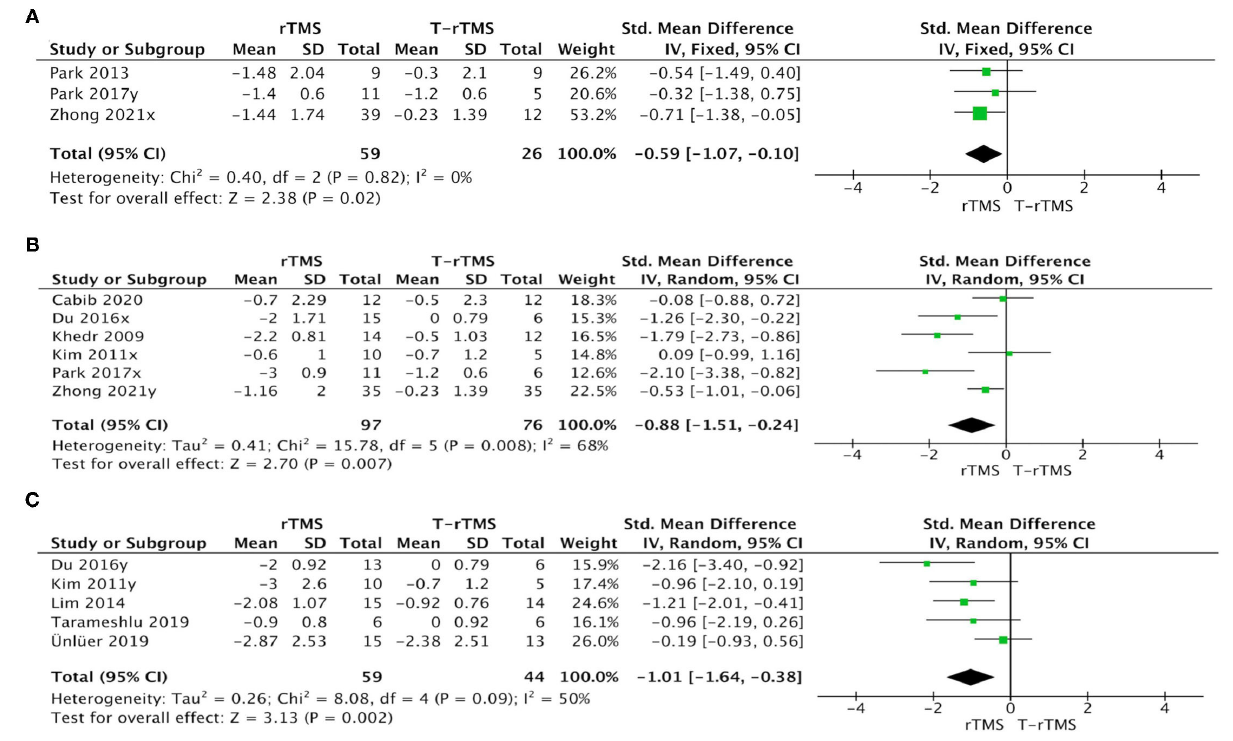
Gow et al. (2004) found that rTMS could regulate the